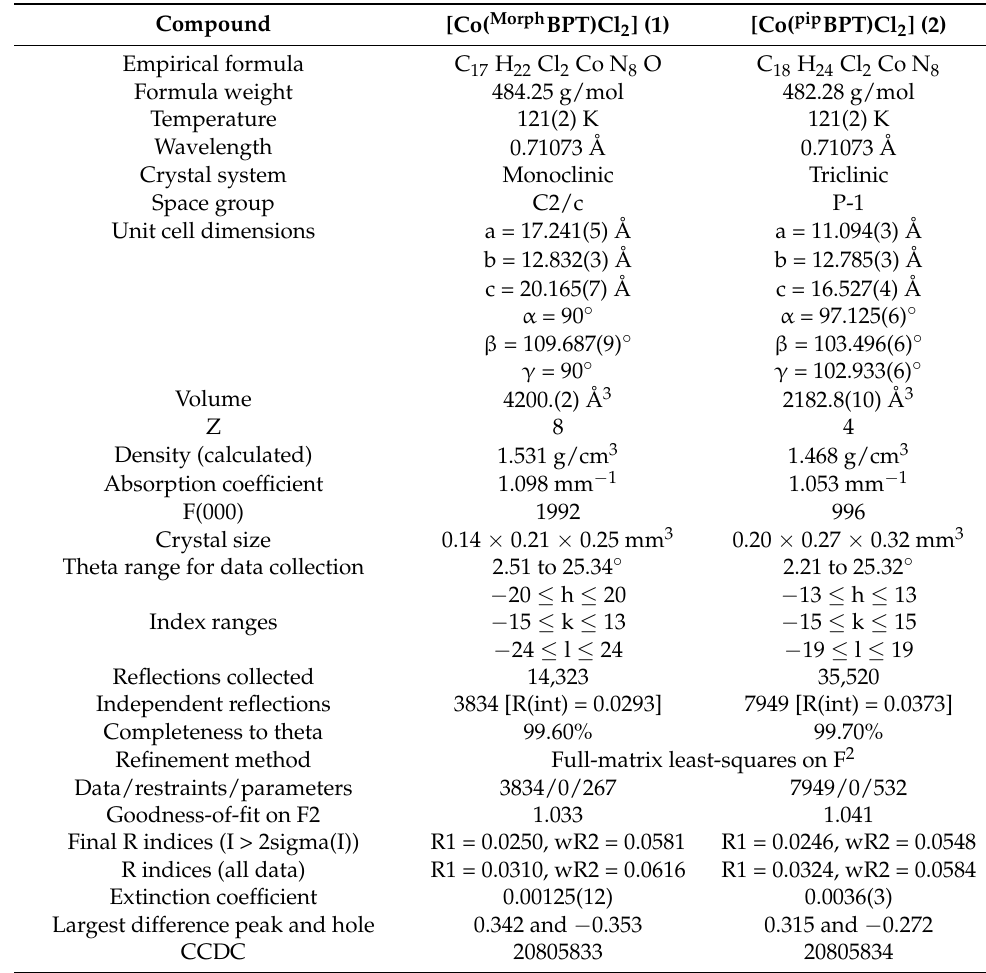
Table 1. Crystal data and structure refinement for the studied